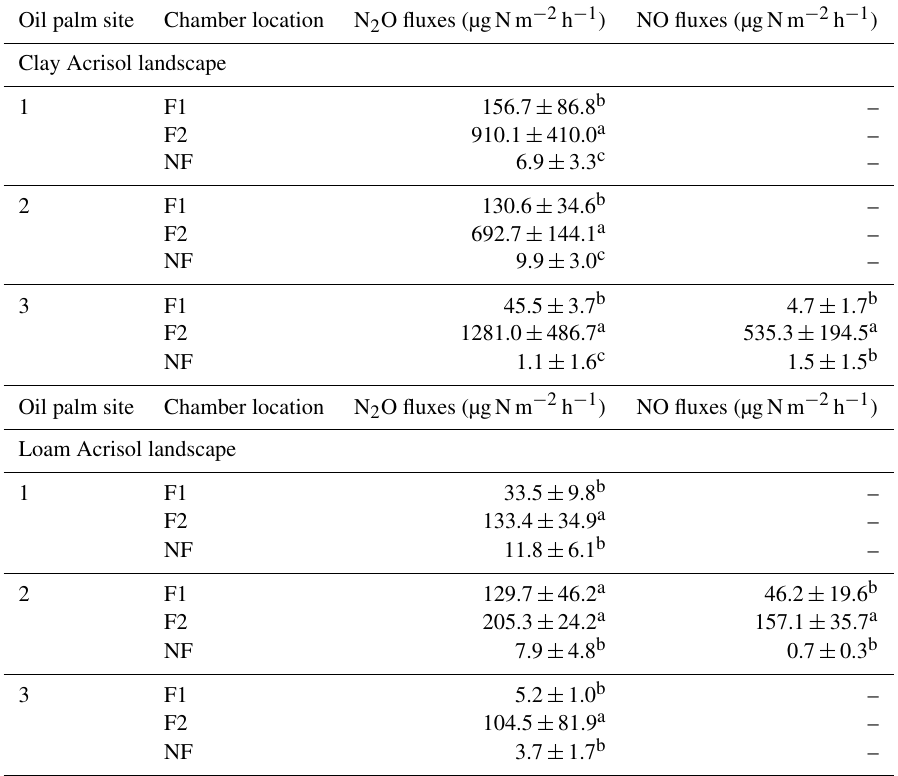
Table 2. Mean ( ± SE, n = 3 oil palm trees) soil N 2 O and NO fluxes from three chamber locations during a fertilization in three (for N 2 O) or one (for NO) smallholder oil palm plantations within each landscape, measured 6 to 11 times during the 3–8.5 weeks following fertilization. Means followed by different letters indicate significant differences among chamber locations within each site (linear mixed-effect models with Fisher’s LSD test at P ≤ 0 . 05). Chamber F1, F2 and NF were placed at 0.3m (with incidental fertilization), 0.8m (fertilized area) and 4–4.5m (non-fertilized area, serving as the reference chamber), respectively, from the stem base. A total of 0.32kgNtree − 1 was applied in the clay Acrisol and 0.26kgNtree − 1 in the loam Acrisol in accordance to the smallholders’